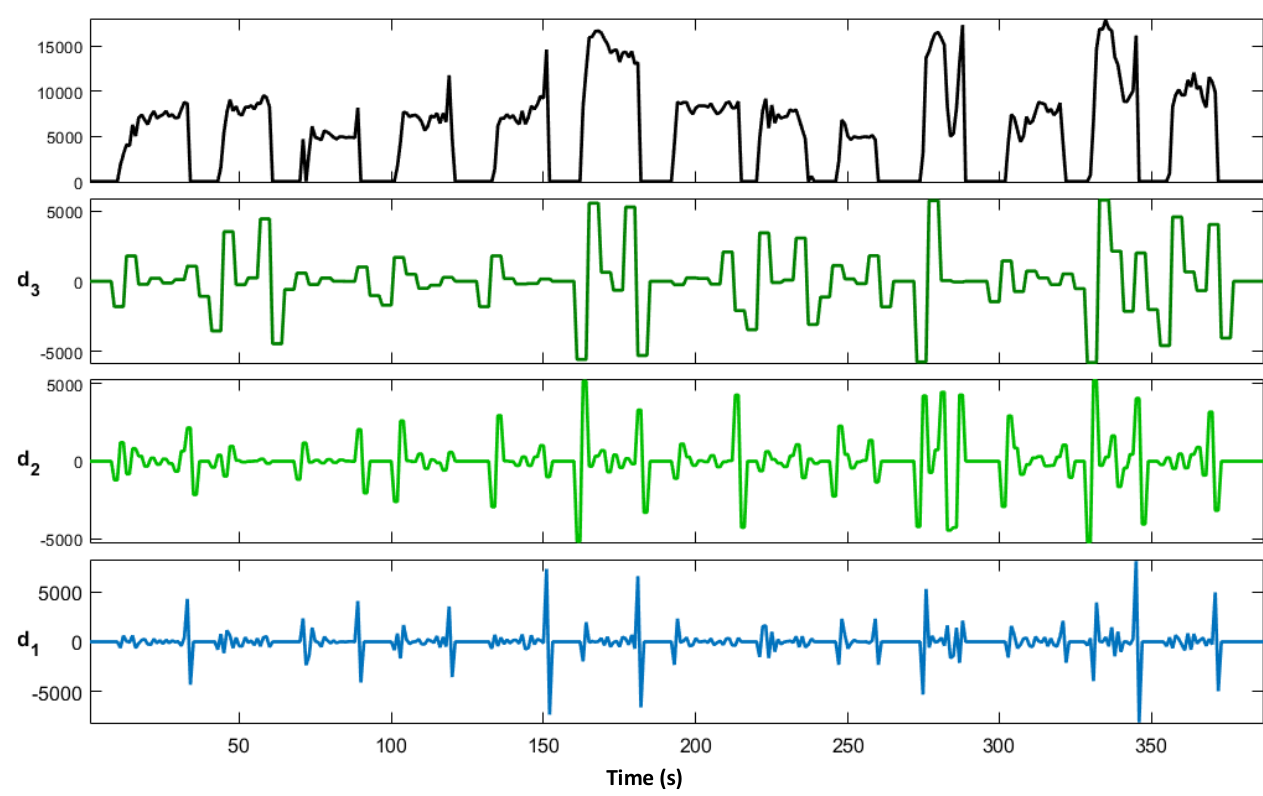
Figure 10. Pressure signal after wavelet transform.